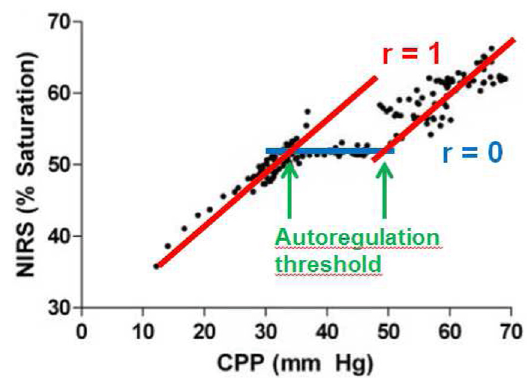
Figure 4. Near-infrared spectroscopy (NIRS)-derived oxygen saturation versus cerebral perfusion pressure (CPP), depicting the cerebral autoregulation curve. The correlations generate the cerebral oximetry index (COx). Adapted from Brady et al.